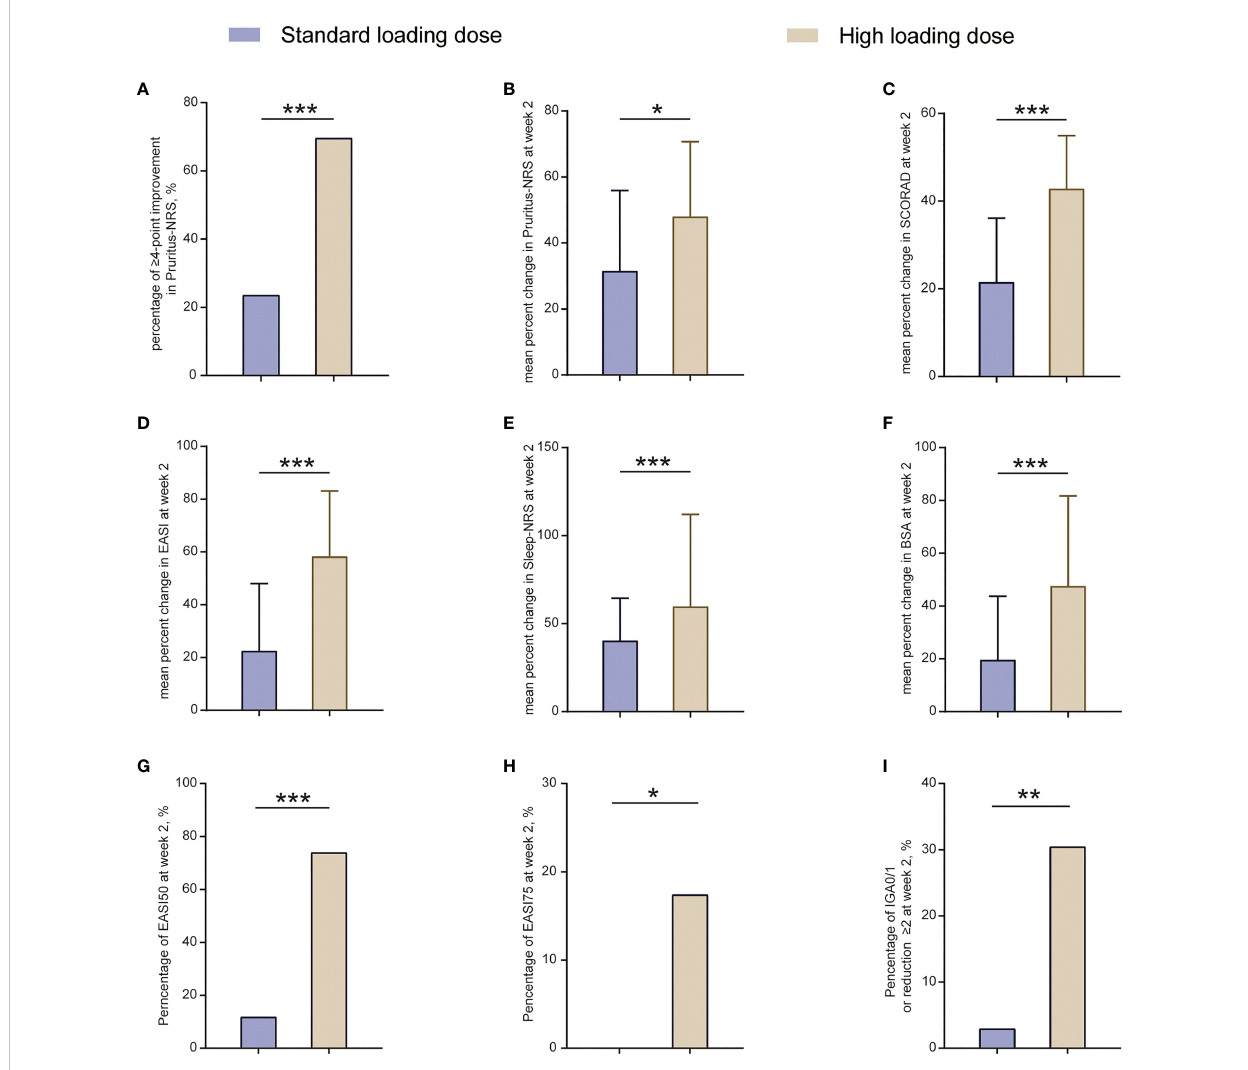
FIGURE 2 Outcomes at week 2 between patients receiving standard loading dose and high loading dose group. BSA, body surface area; EASI, Eczema Area and Severity Index; EASI50, at least 50% improvement from baseline in EASI; EASI-75, at least 75% improvement from baseline in EASI; IGA, Investigator ’ s Global Assessment; NRS, Numerical Rating Scale; SCORAD, Scoring Atopic Dermatitis. * P < 0.05, ** P < 0.01, *** P <